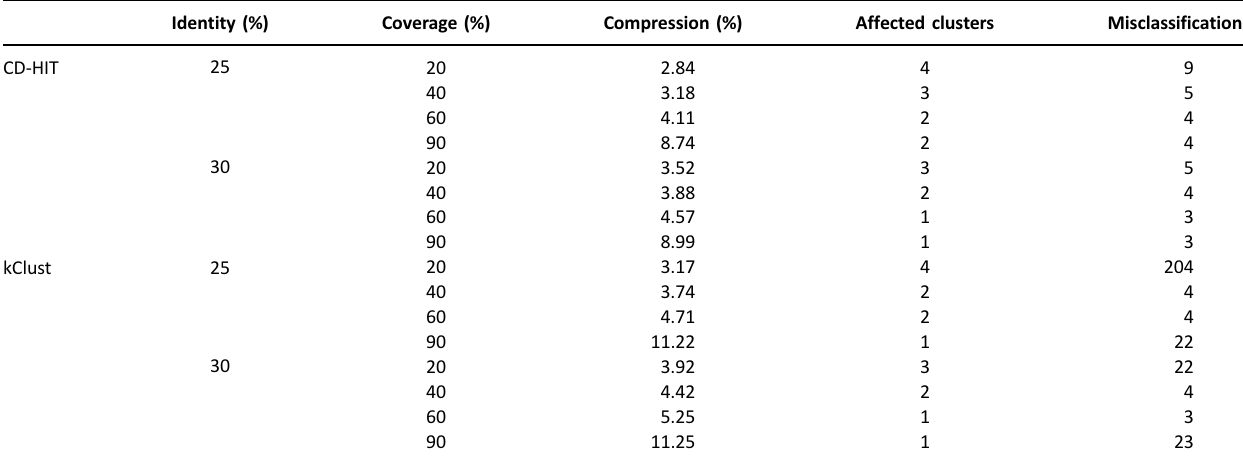
Table 3. CD-HIT and kClust in the